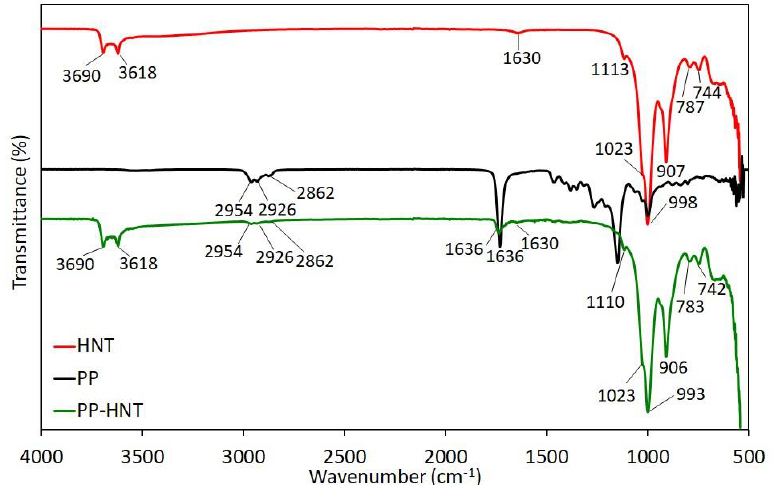
Figure 3. FTIR spectra of HNT, polyester plasticizer and PP-HNT in the 4000–500 cm −1 region.